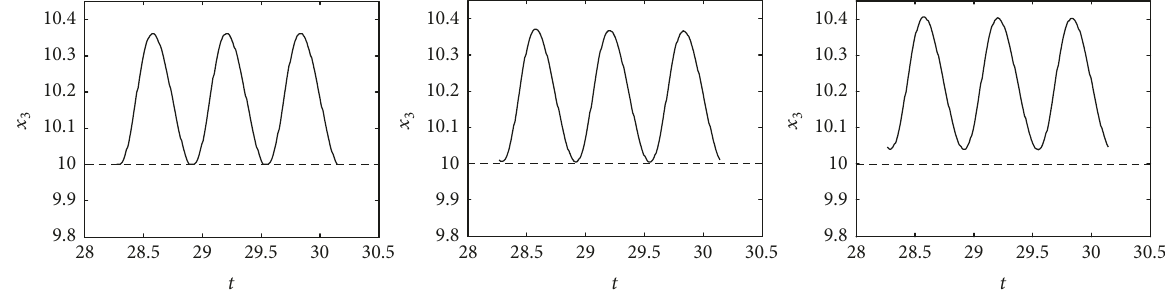
Figure 12: Time history